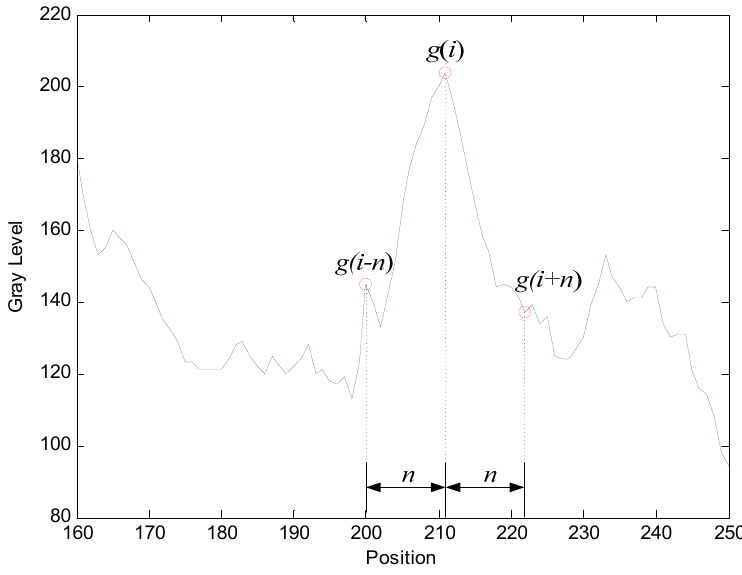
Figure 10. Parameters of gray level gradient